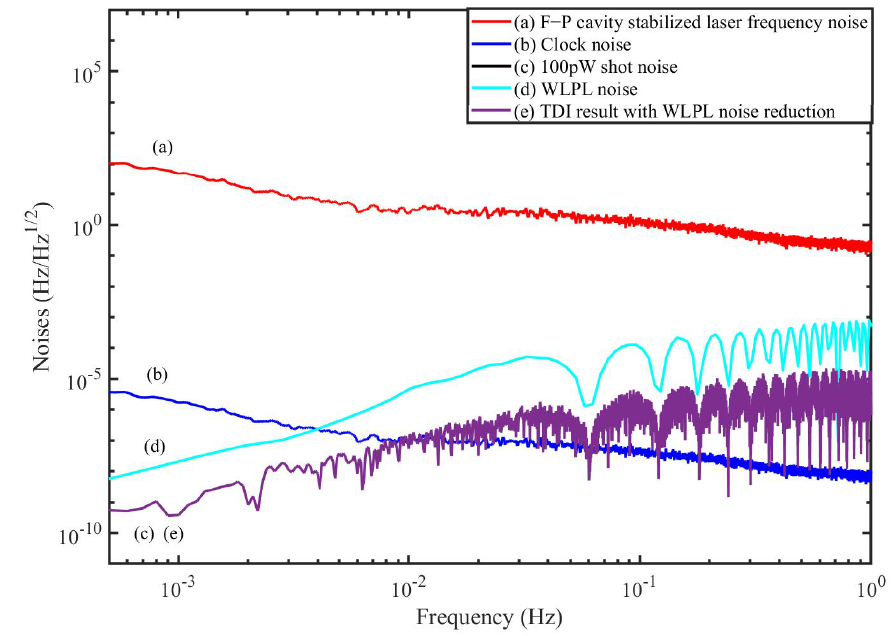
Figure 9. TDI results of the simulation with WLPL noise